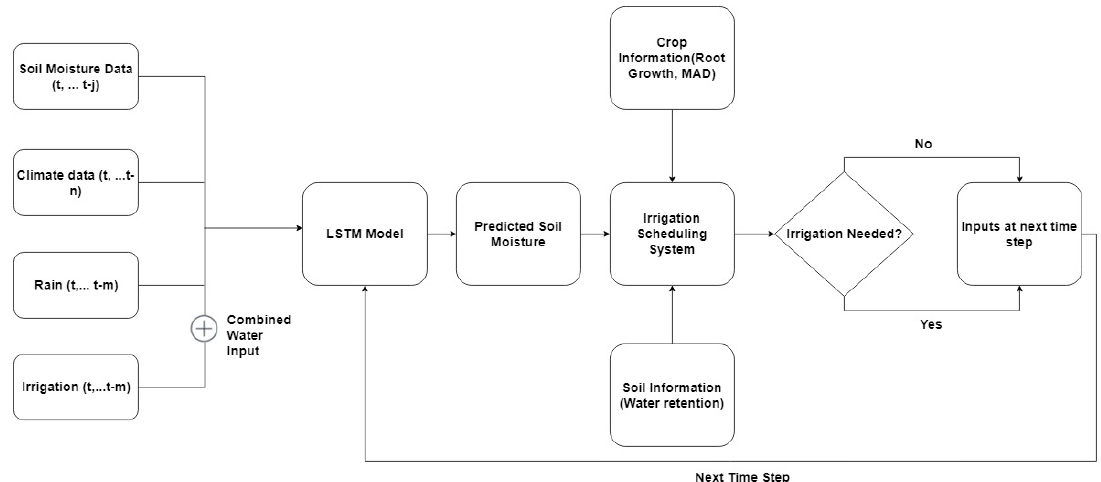
Figure 5. Block diagram of the predictive irrigation scheduling system. t is the time in days, m, n, and j are past time steps.